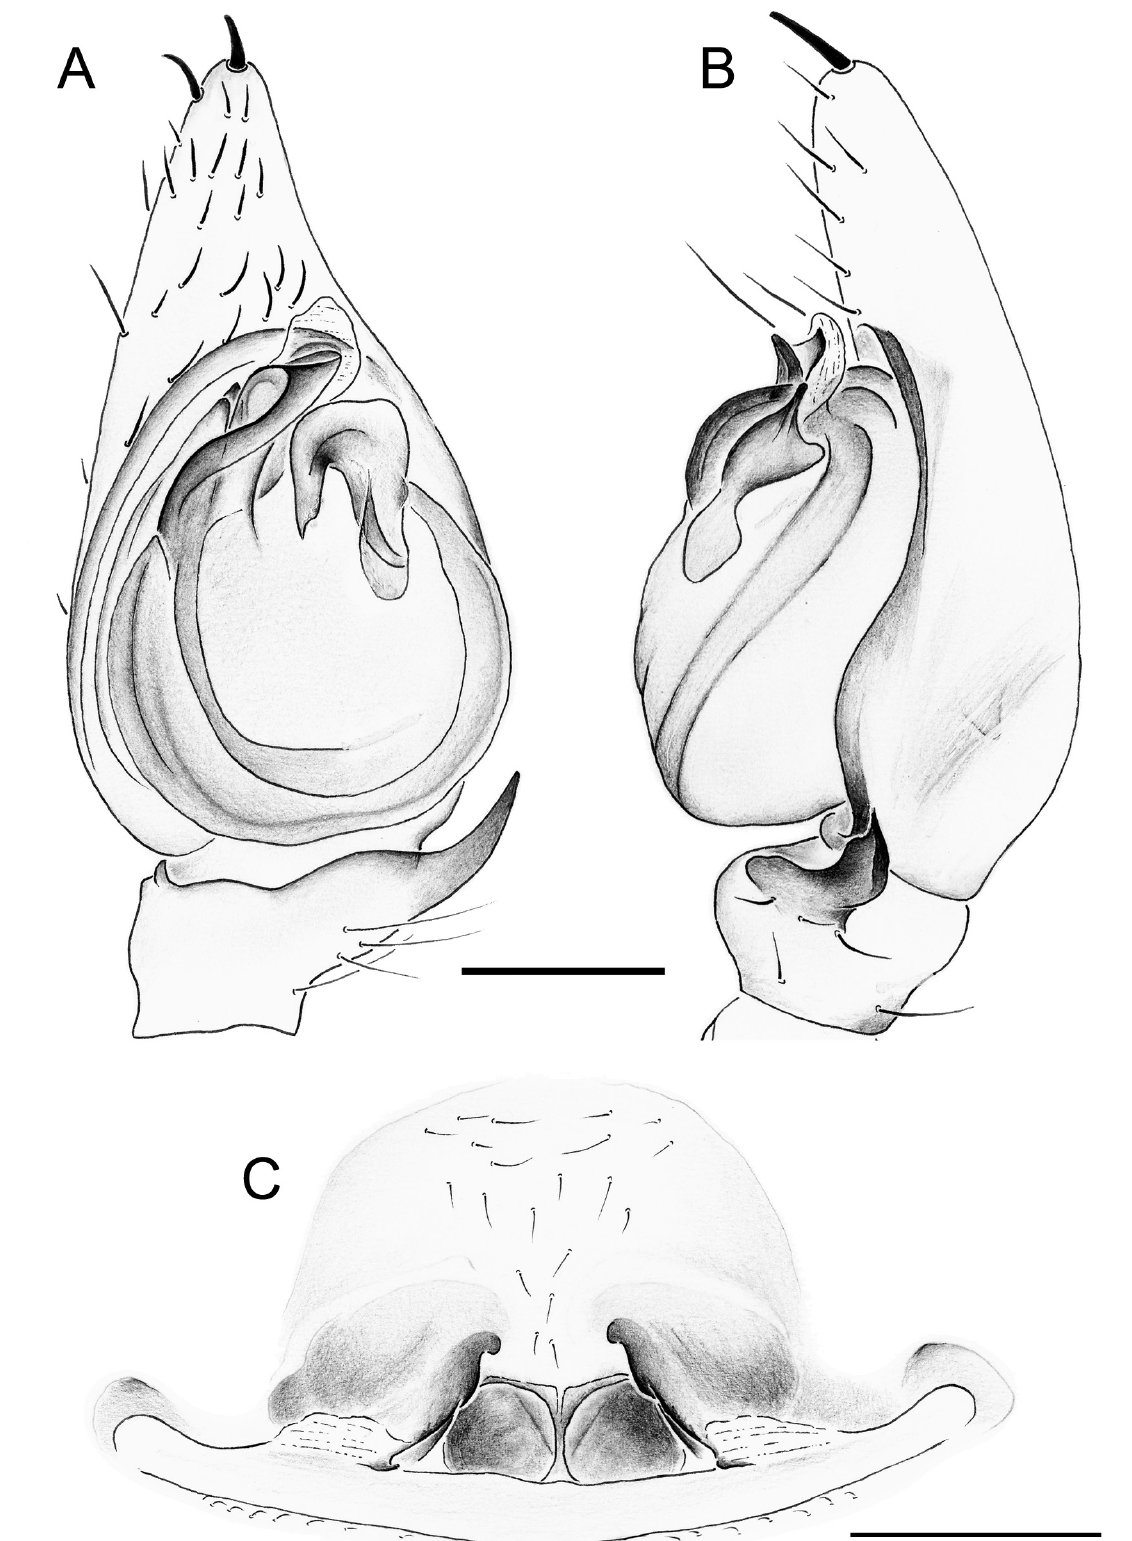
Fig. 6. Acanthinozodium sahelense sp. nov. A–B . Holotype ♂. A . Palp, ventral view. B . Idem, retrolateral view. C . ♀ from Faro Game Reserve (MRAC 221205), epigyne, ventral view. Scale bars = 0.2